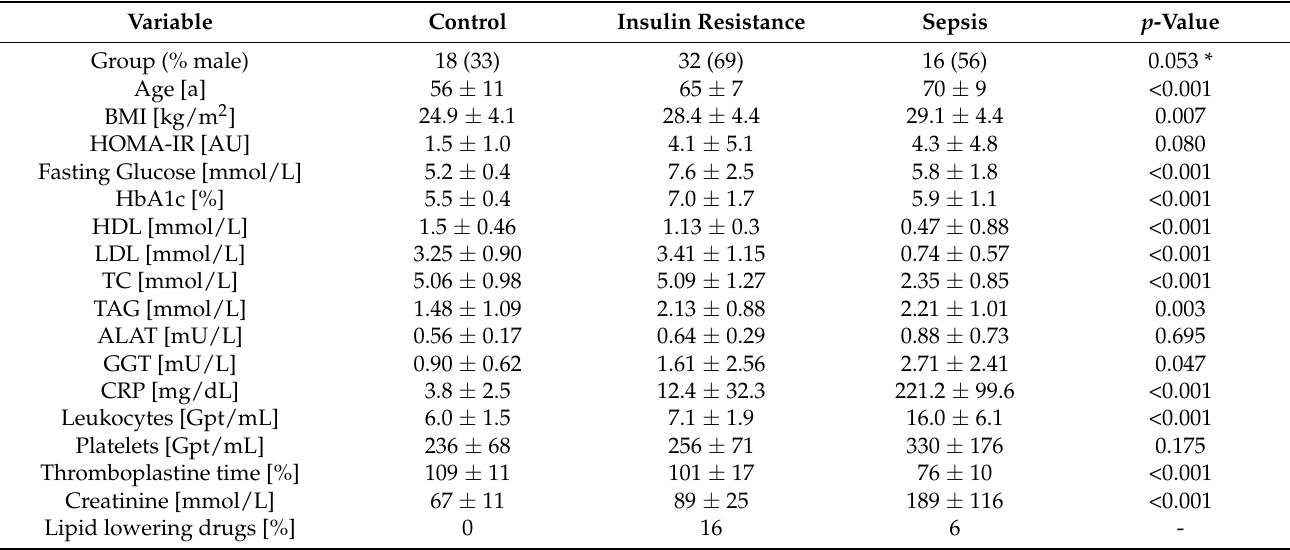
Table 1. Baseline characteristics of study